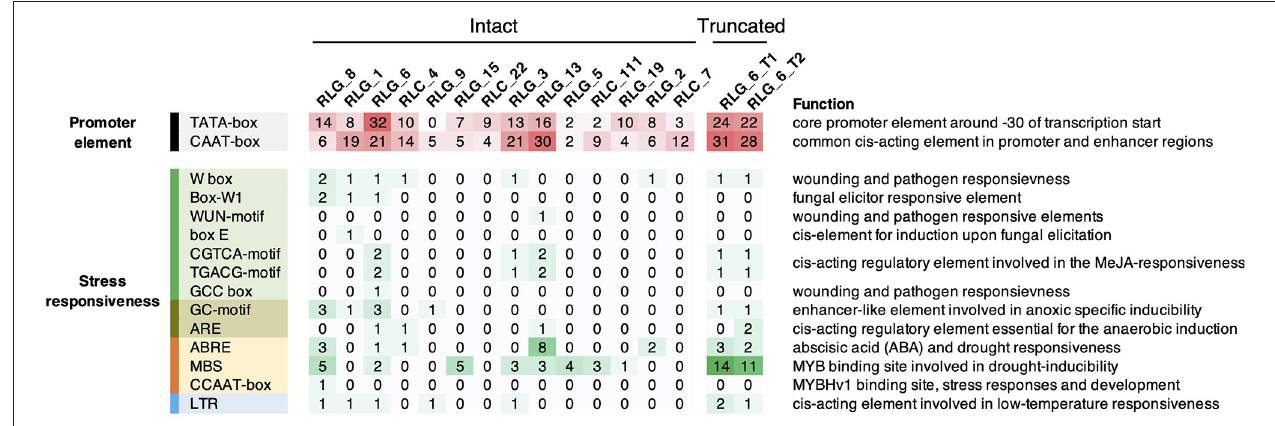
FIGURE 6 | Summary of cis -acting regulatory elements (CREs) in the LTRs of Gypsy and Copia families. Only families with more than ten copies in S. alba were shown. Also shown are CREs in the full length of the two truncated elements (RLG_6_T1 and RLG_6_T2) which significantly correlated with their nearby genes in expression levels. Color depths and numbers indicate the abundance of specific